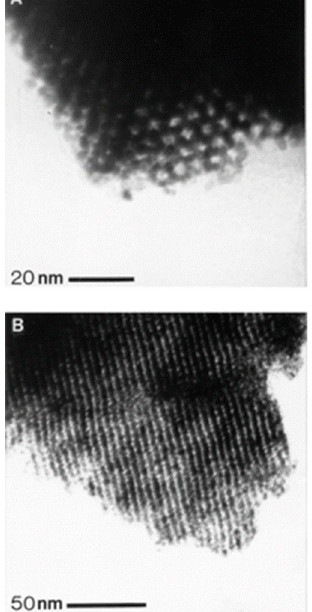
Figure 3. Transmission electron micrographs showing the ( A ) end view and ( B ) side view, of the pores. The photos are of a hexagonal liquid crystalline solution containing 42 weight% of a non-ionic surfactant octaethyleneglycol monohexadecyl ether, 29 weight% water, and 29 weight% hexachloroplatinic acid hydrate. Reprinted with permission from Attard et al. Science 1997 , 278 , 838–840.